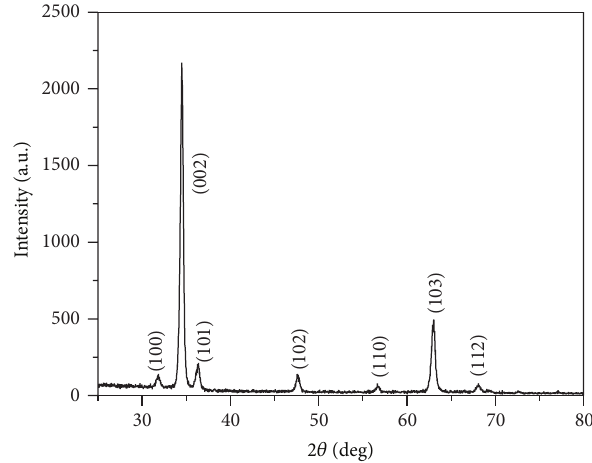
Figure 1: XRD pattern of the as-prepared ZnO nanorod arrays.